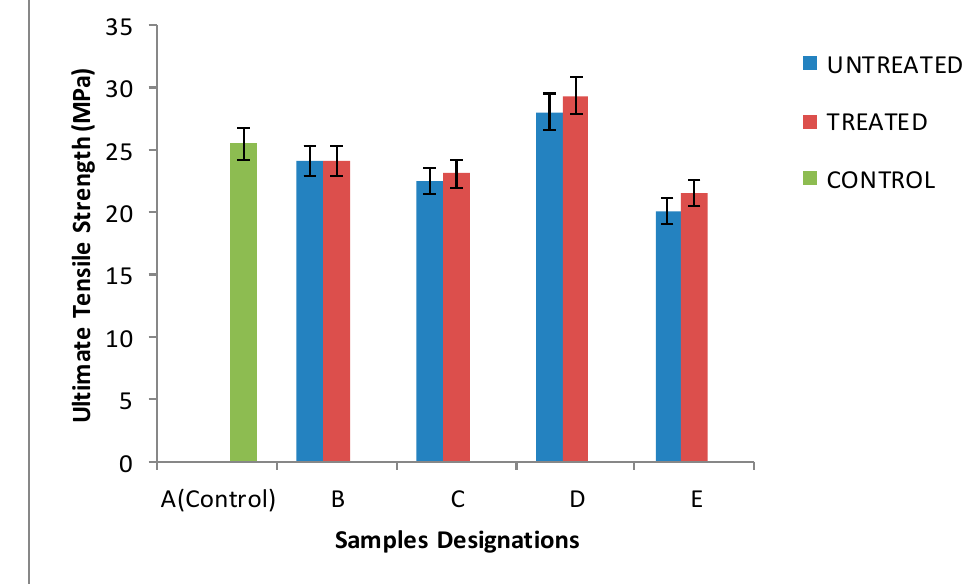
Figure 6. The ultimate tensile strength of the control sample and the developed composites.